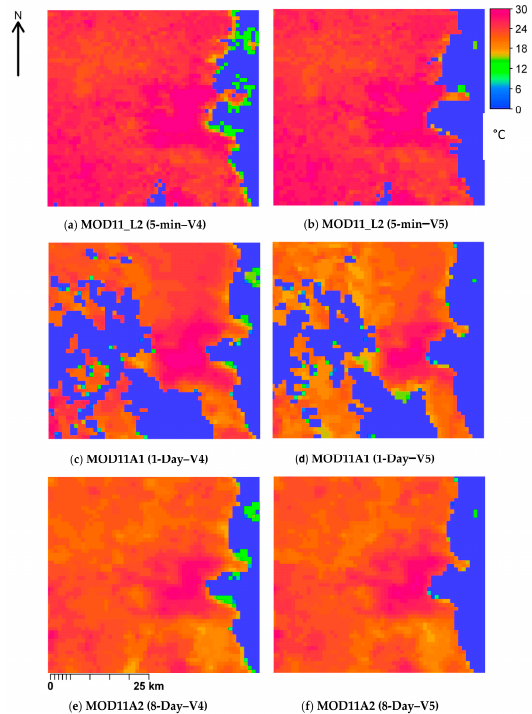
Figure 2 . MODIS/Terra land surface temperature (in °C) products used in this study including, ( a , b ) 5 min product; ( c , d ) 1 day product; and ( e , f ) 8 days product; with two different collection methods (V4 and V5), at 960 m resolution.